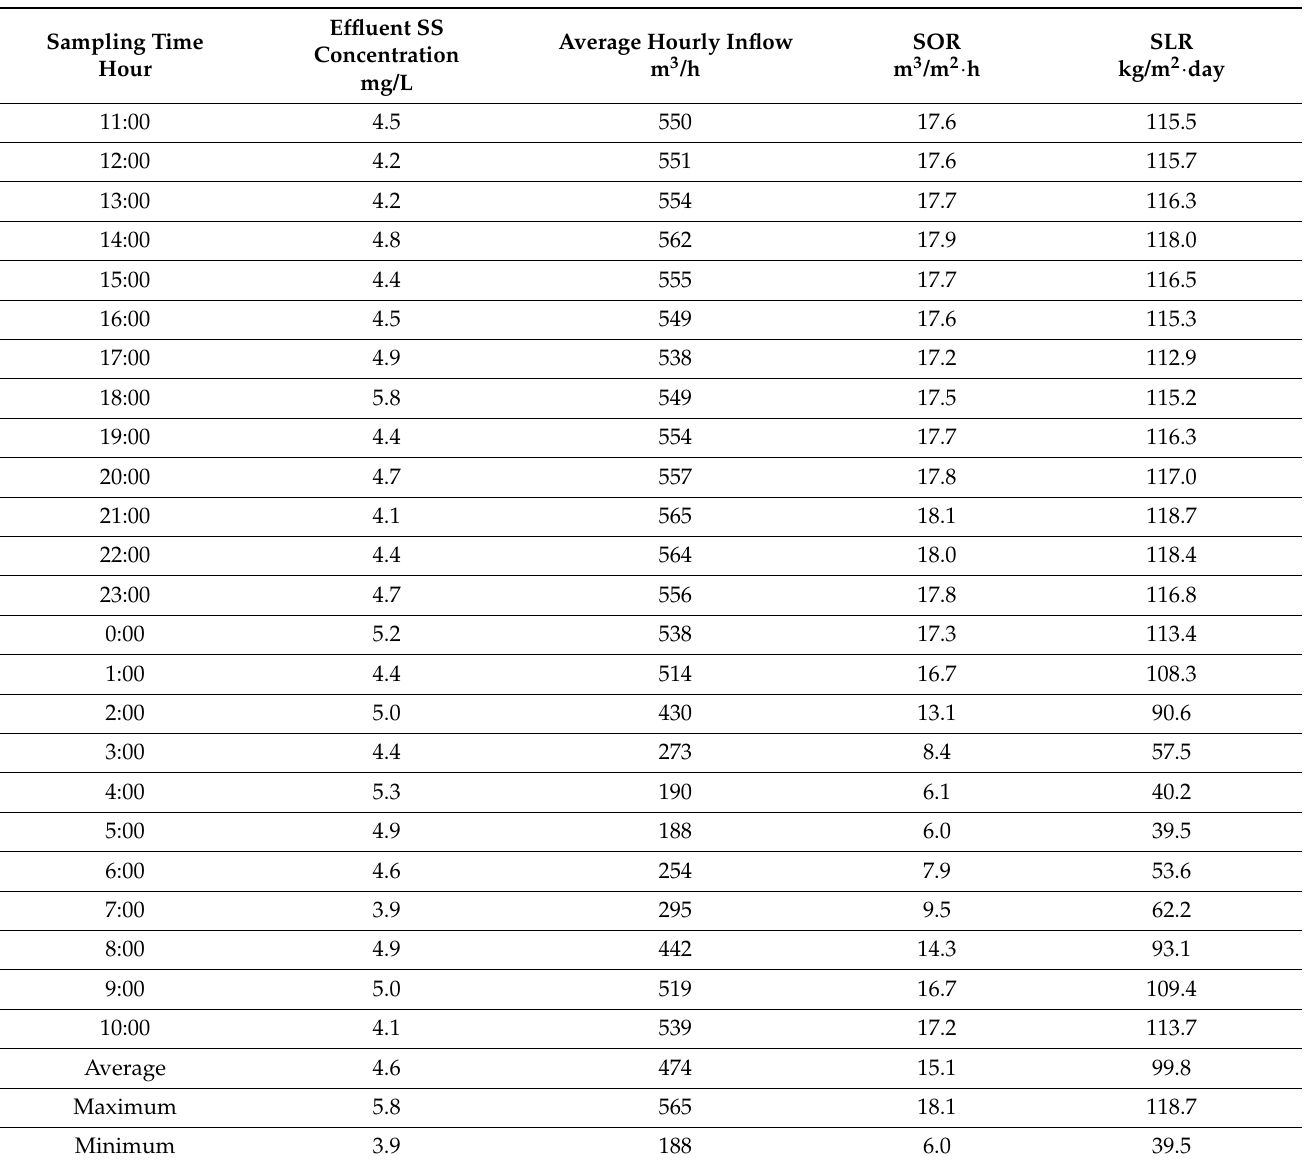
Table 7. Average hourly secondary effluent SS concentrations and corresponding average hourly inflows, SORs, and SLRs at the secondary clarifier at plant